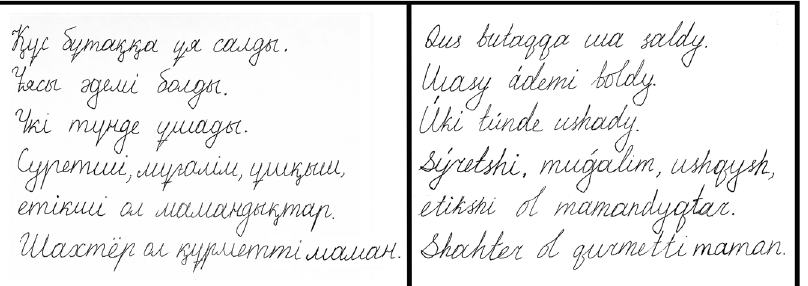
Fig. 3 Two handwriting samples produced by the same person. The text written in the Cyrillic alphabet is on the left, while the text written in the Latin alphabet is on the